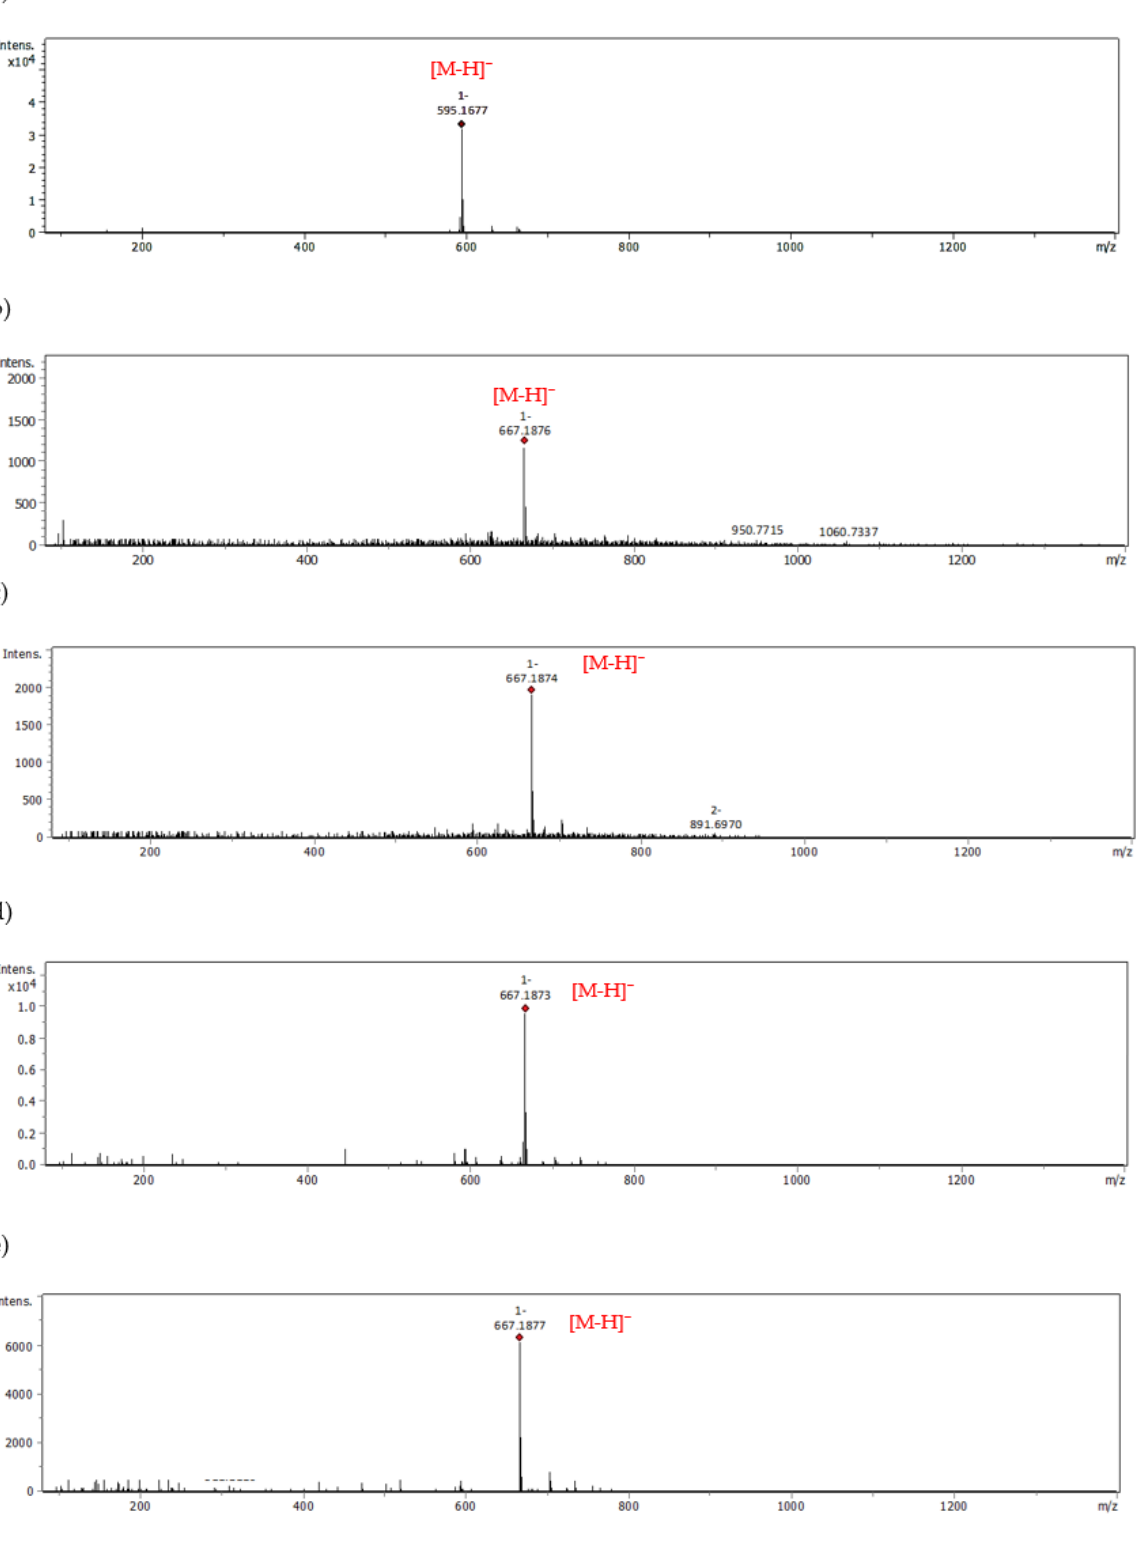
Figure 8. MS spectra of eriocitrin and eriocitrin-MGO; ( a ) authentic standard, ( b ) mono-adduct